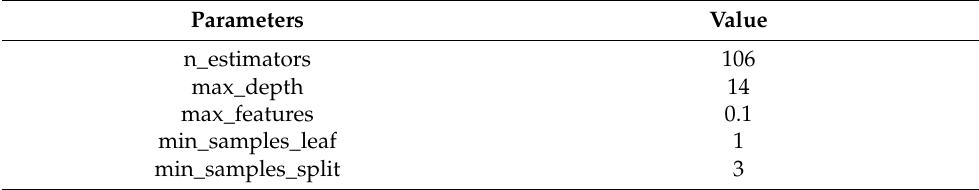
Table 6. Parameters of SMD-RF